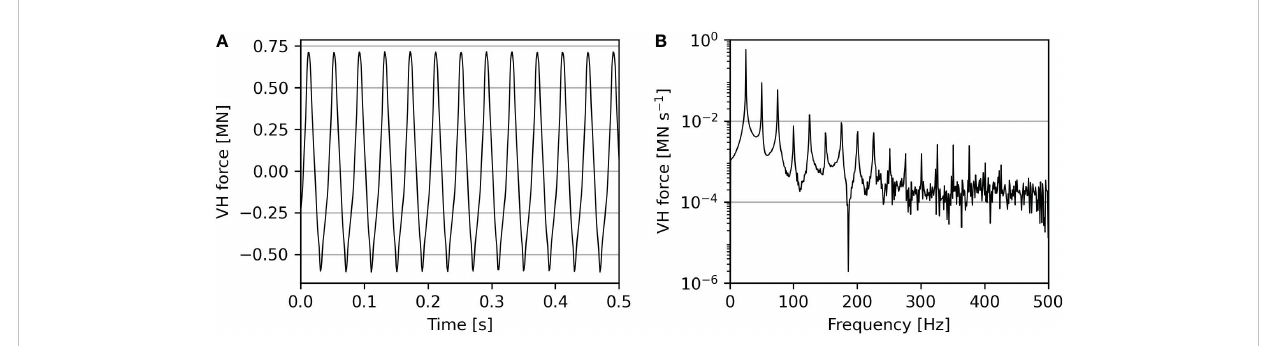
FIGURE 4 Estimated vibratory force exerted by the installation tool at the pile head as a function. (A) shows the time signature and (B) the amplitude spectrum of the force (Tsetas et al., 2023a).